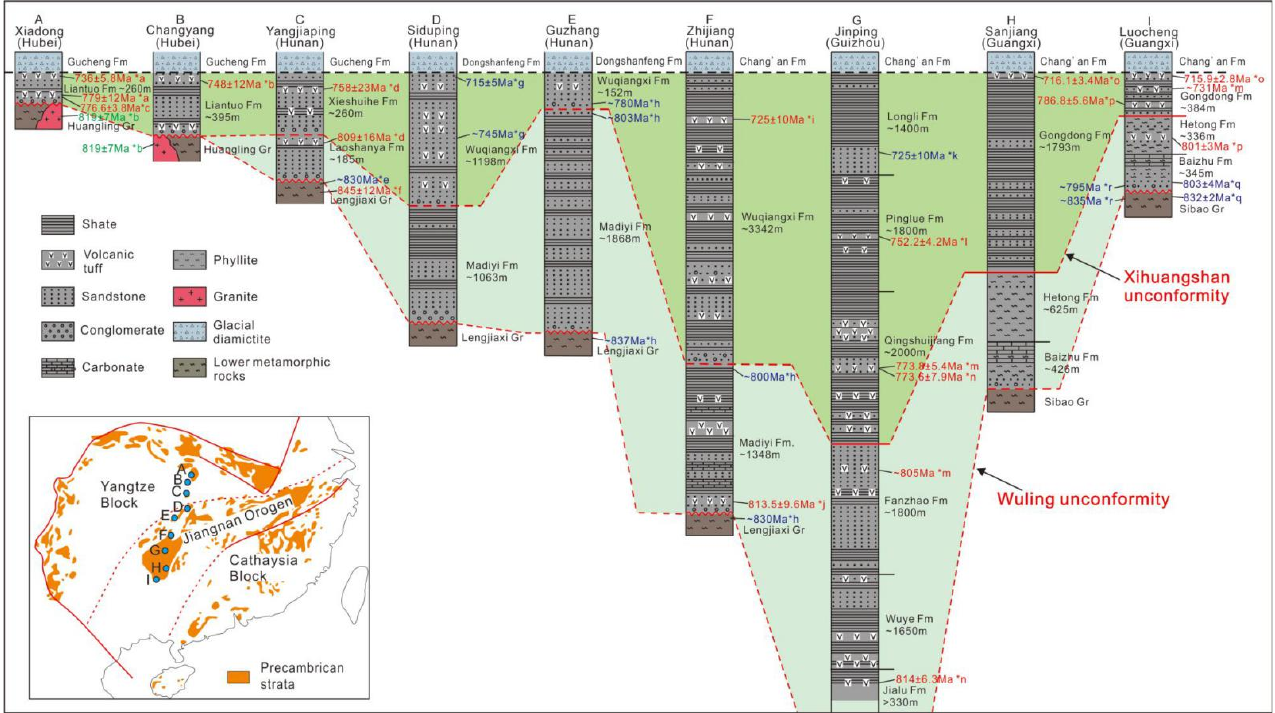
Figure 9. Stratigraphic correlation of the Neoproterozoic strata across the Yangtze Block, with most of the published U − Pb ages shown in each stratigraphic column. ( A ) Xiadong section in Hubei Province; (B) Changyang section in Hubei Province; ( C ) Yangjiaping section in Hunan Province; ( D ) Siduping section in Hunan Province; ( E ) Guzhang section in Hunan Province; ( F ) Zhijiang section in Hunan Province; ( G ) Jinping section in Guizhou Province; ( H ) Sanjiang section in Guangxi Province; ( I ) Luocheng section in Guangxi Province. The ages were shown in different colors according to the analyzing rock types (red: tuff/tuffaceous siltstone beds; blue: clastic rocks; green: magmatic rocks). * represents data source: (a) Du et al. [88]; (b) Ma et al. [89]; (c) Lan et al. [87]; (d) Yin et al. [83]; (e) Wang et al. [41]; (f) Sun et al. [90]; (g) Song et al. [55]; (h) this study; (i) Zhang et al. [91]; (j) Gao et al. [85]; (k) Qin et al. [52]; (l) Liu et al. [92]; (m) Wang et al. [76]; (n) Gao et al. [87]; (o) Lan et al. [93]; (p) Gao et al. [94]; (q) Su et al. [40]; (r) Ma et al. [39].